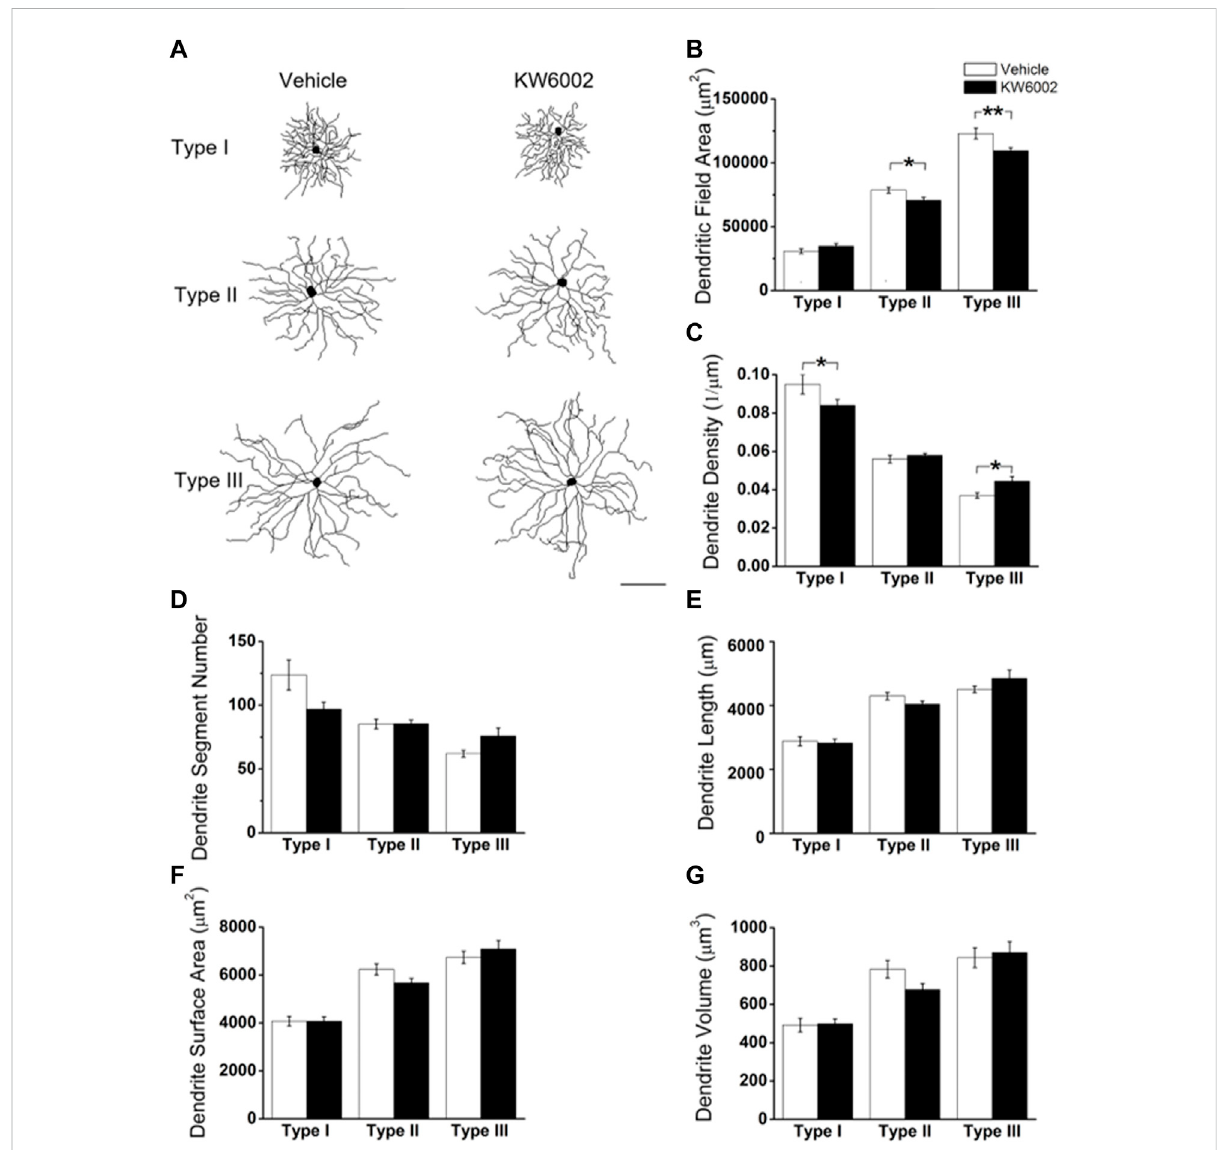
FIGURE 3 KW6002 differentially affected the dendritic morphology of RGCs during the development. (A) Representative 3D reconstructions of the three RGC types from the vehicle-treated and KW6002-treated mice. (B – G) Comparative analysis of dendritic fi eld area (B) , dendrite density (C) , dendrite segment number (D) , dendrite length (E) , dendrite surface area (F) and dendrite volume (G) in each RGC type between the vehicle-treated and KW6002-treated group. Data represent mean ± SEM. * p < 0.05; ** p < 0.01. Scale bar, 100 μ